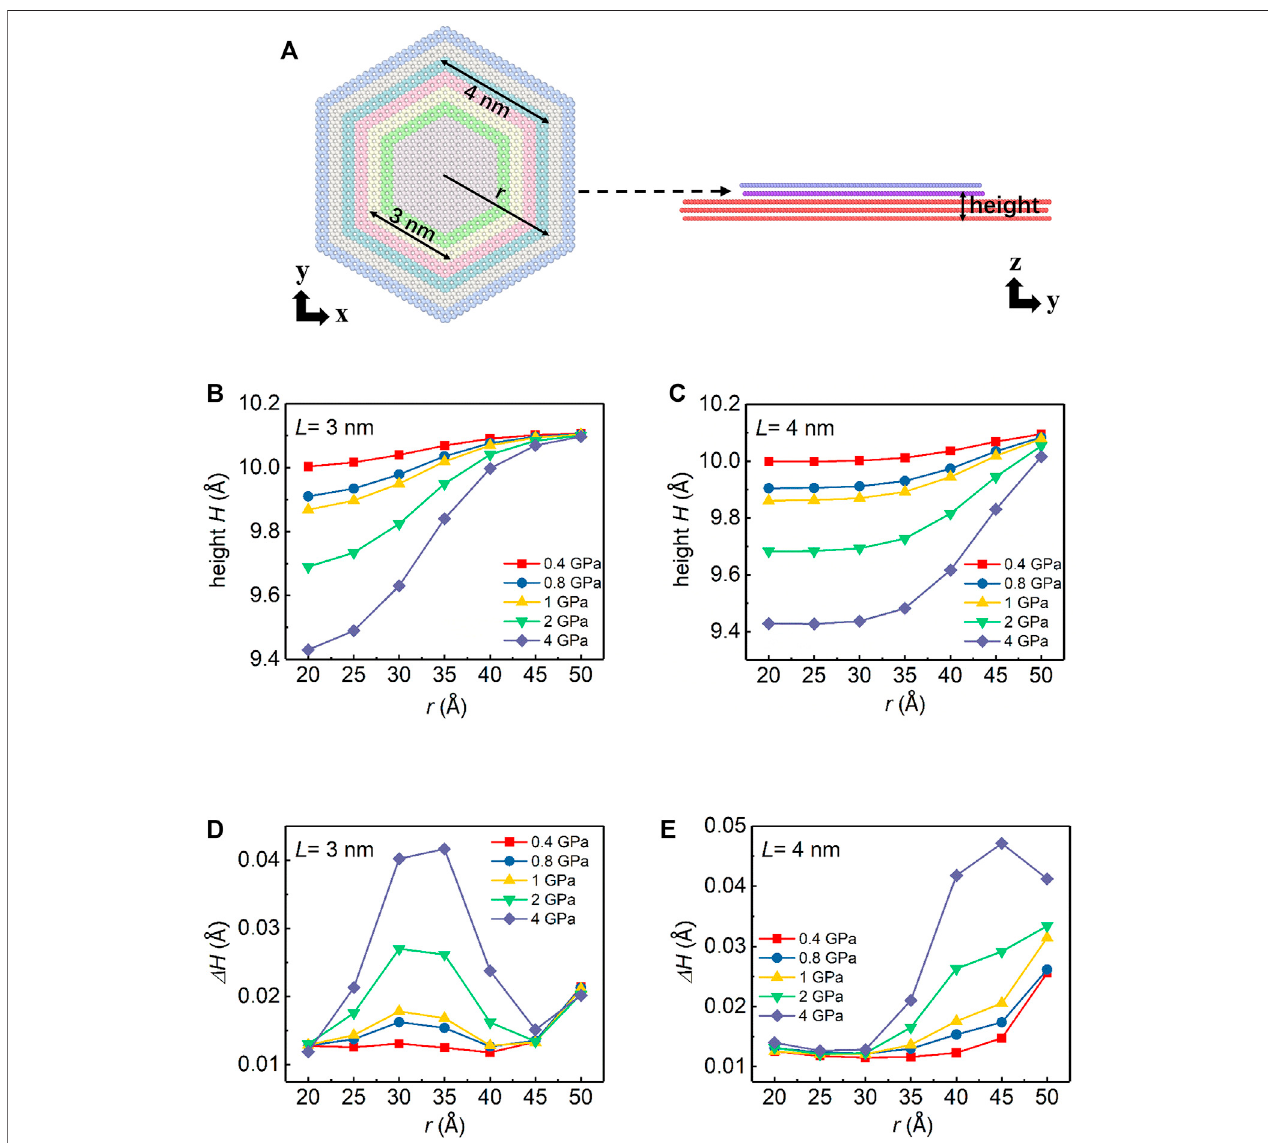
FIGURE 2 | (A) Schematic sketch of the position of atoms on the graphene fl ake (the bottom layer of the graphite fl ake as indicated by the dashed arrow) with different colors. (B) Side view of the simulation model illustrating the layer we focus and its height H . (C – D) Spatial distribution of the height H shown in Panel (B) vs. loading pressure with different L . (E – F) Spatial distribution of the standard deviation of the height Δ H vs. loading pressure for different L .